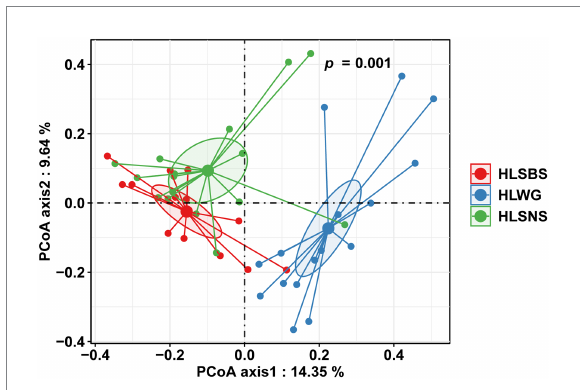
FIGURE 3 Principal coordinate analysis (PCoA) of ectomycorrhizal (EM) fungal community composition based on Bray–Curtis similarity. EM fungi were clustered, and the center of gravity was computed for each site. HLSBS, HeLanShan-BeiSi; HLWG, HaLaWuGo; and HLSNS,